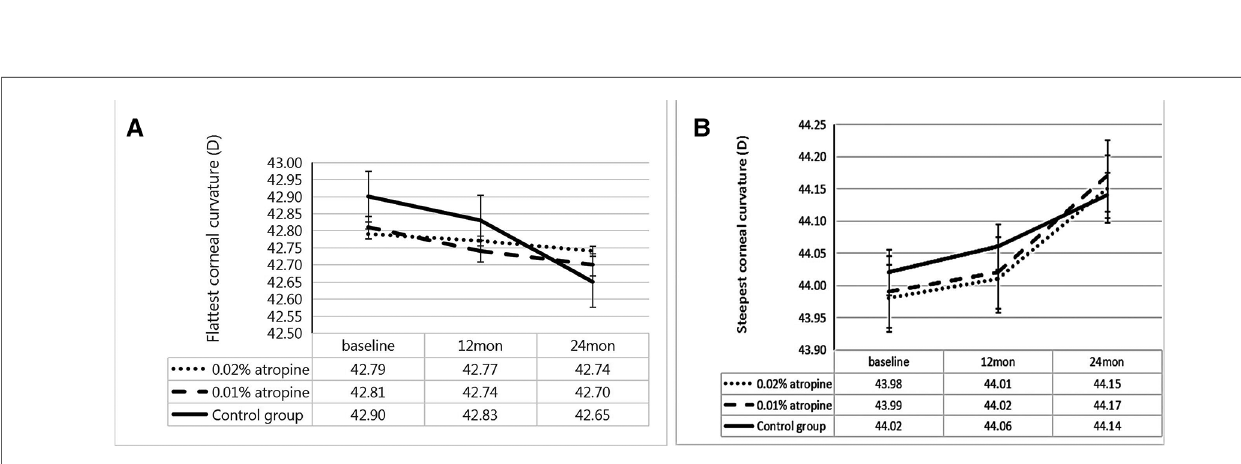
FIGURE 4 Measurement of fl attest corneal curvature ( A ) and steepest corneal curvature ( B ) over